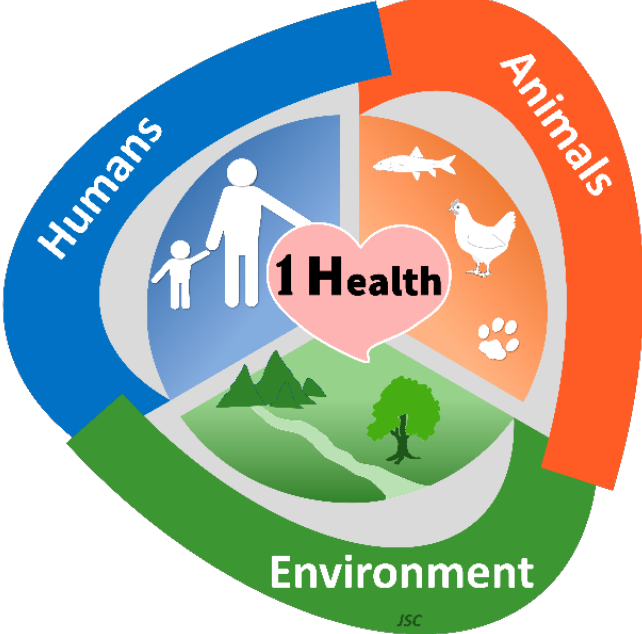
Figure 1. The tridimensional concept of One Health toxicology. Artwork is a gift from Professor João Soares Carrola (JSC) of the University of Trás-os-Montes and Alto Douro. Historically focused on zoonoses [7], the concept of One Health has paid less attention to animal, human, and environmental exposure to toxics. The application of the One Health concept to toxicology and pharmacology is obvious, as these specialists on xenobiotics work in synergy with other medical and nonmedical professionals. Despite the variability in the dose response and toxicokinetics between domestic and wildlife animals, plants, and humans, biochemical and physiological systems are highly conserved among species, meaning that the toxic effects can be common to them [8]. This suggests that, if a specific group of species is at risk, other groups of species can be also affected. Therefore, the term “One Toxicology” emerged to encourage more efficient collaborative research, data, and knowledge sharing, as well as stewardship actions among groups of toxicologists [8]. Some examples of One Health toxicology research include studies on the effects of pollution on aquatic ecosystems, the impact of pesticides on honeybee populations and other pol- linators, and the health risks associated with exposure to toxics trafficked via foods. In addition, some tragedies highlight the concept of One Health applied to toxicology. The Minamata Bay (Japan) tragedy in the 1950s, due to mercury exposure, is one example since marine microorganisms up the food chain, and how the poisoned and dead floating fish, predators, and scavengers should have served as sentinels and alarm for this outbreak of environmental illness, before its effects were felt by the human population [9]. The great London fog, which blanketed the British capital for five days in December 1952, caused more than 12,000 human deaths [10]. The etiology was only discovered almost one